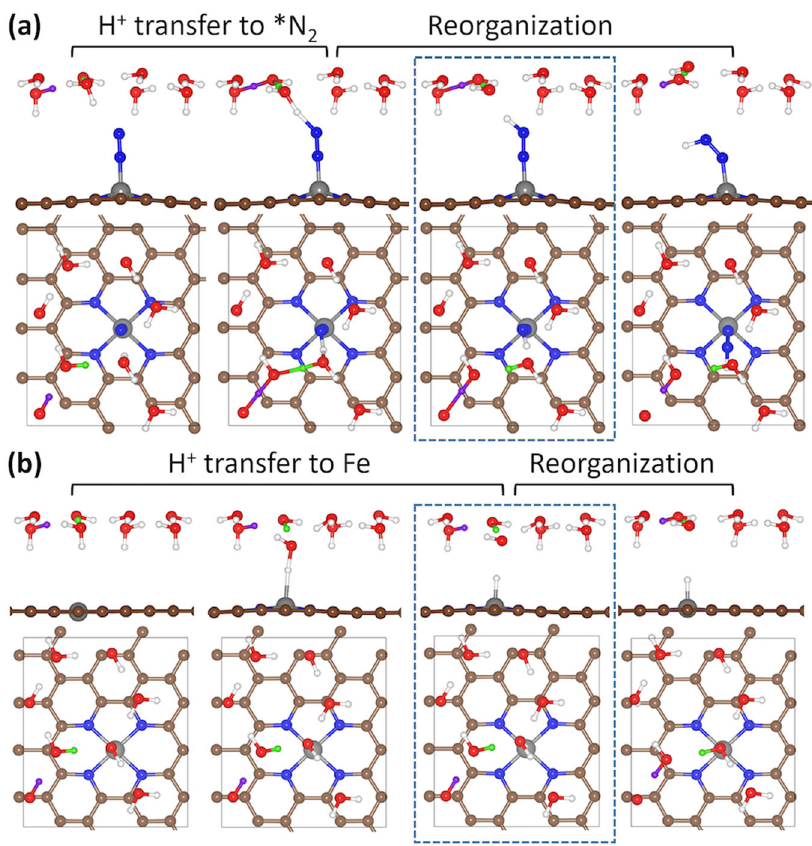
Fig. 5 Reaction pathways of *H formation and *NNH formation. Reaction pathway for a *N 2 + H 2 O → *NNH + OH − and b * + H 2 O → *H + OH − . Side view and top view are listed in the upper panel and lower panel, respectively. Transition state of each reaction is highlighted with blue dashed box. Green and purple balls represent the transferred H atoms during